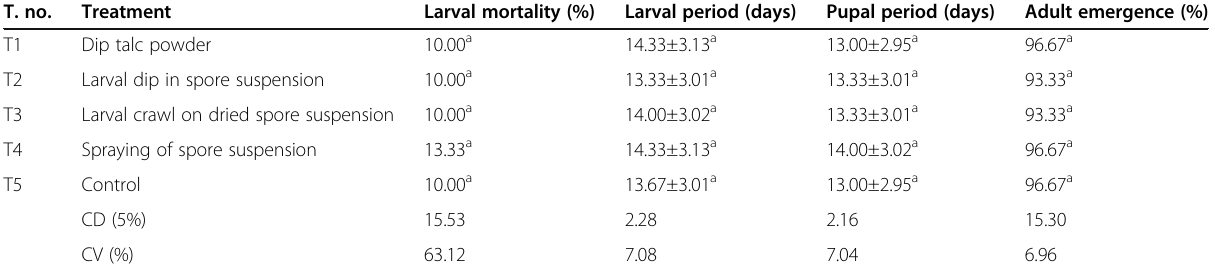
Table 9 Effect of Lecanicillium lecanii on some biological parameters of Mallada boninensis T. no.